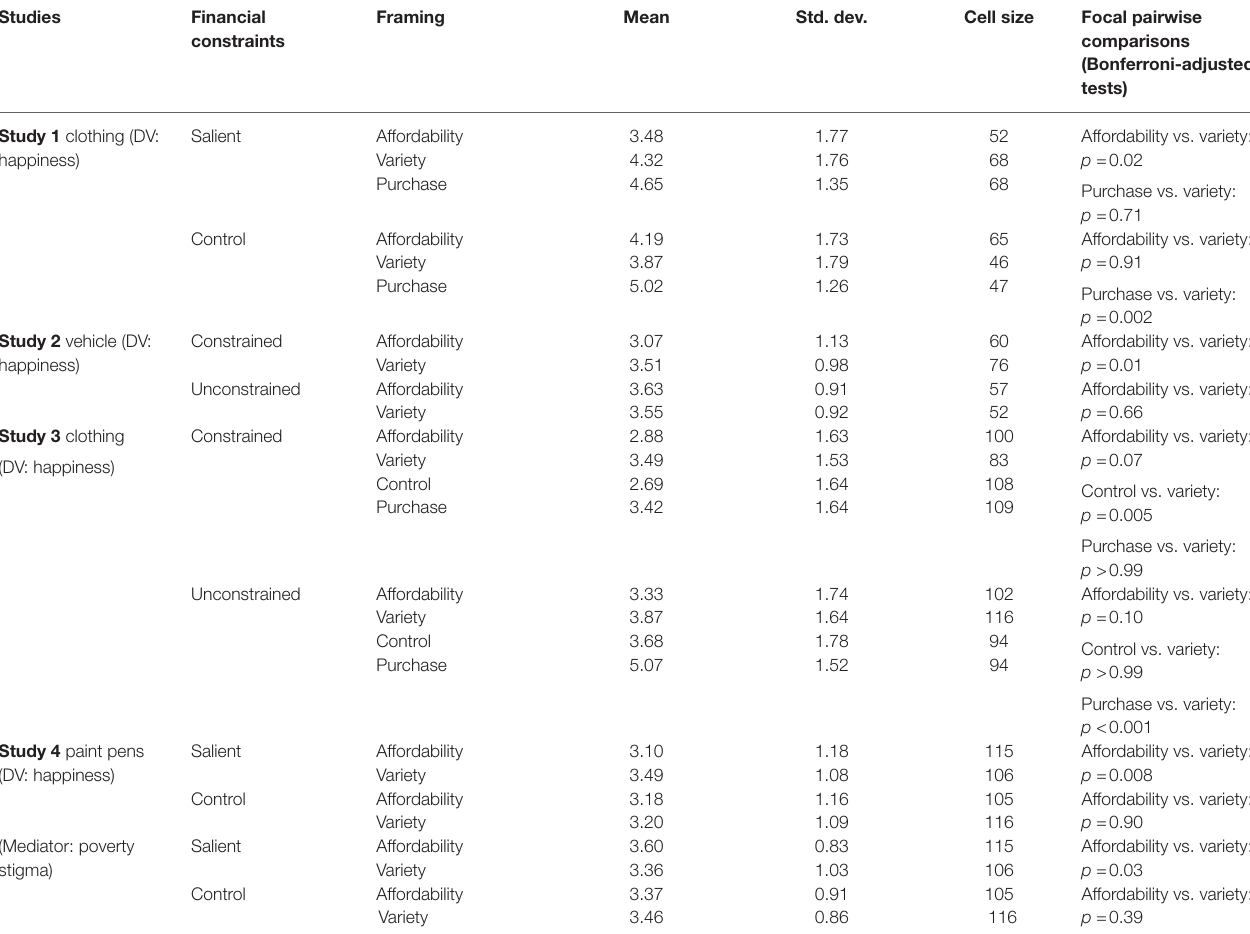
TABLE 3 | Studies 1–4 results summary.